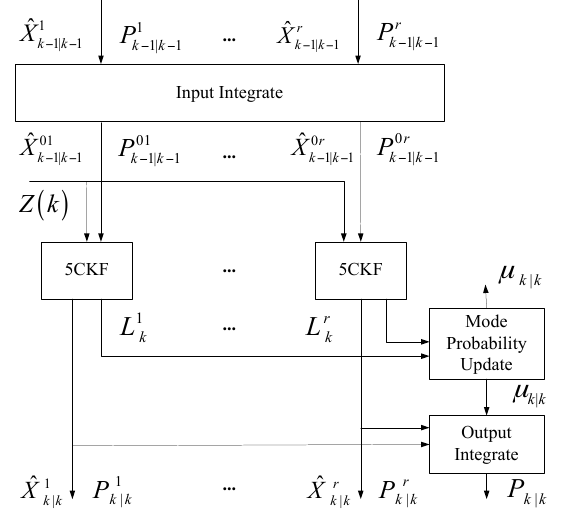
Figure 1. IMM-5CKF structure diagram.